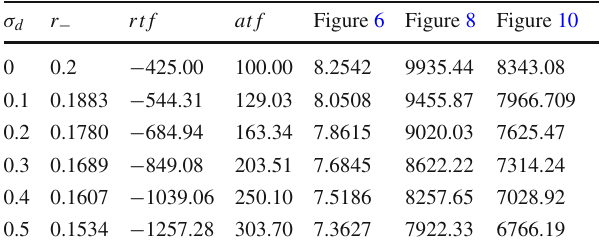
Table 2 Location of Cauchy horizon for chosen values of the dust parameter